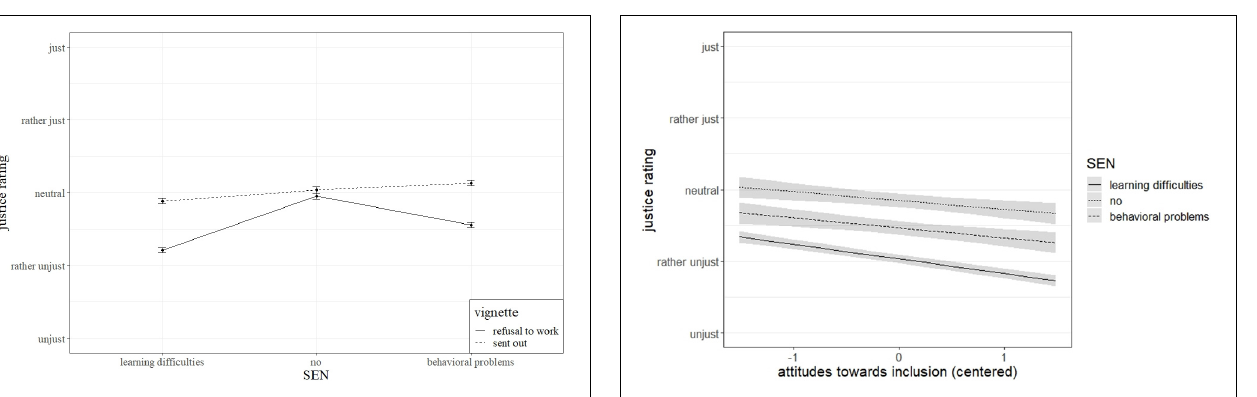
FIGURE 1 | Interaction of vignette and special educational need (SEN). FIGURE 2 | Interaction of attitudes toward inclusion and special educational